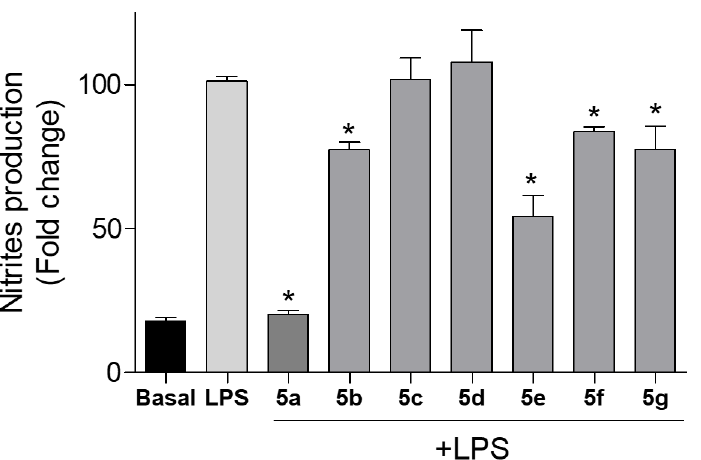
Figure 5. Effects of compounds 5a – 5g on NO release in microglial cells. Bv.2 microglial cells were cotreated with the compound at 10 μ M and 200 ng/mL LPS for 24 h. Nitrite accumulation in the culture media was measured using the Griess reagent. Results were expressed as a fold change relative to the LPS condition and mean ± SD (n ≥ 3 independent experiments performed in duplicate). Significant differences were determined by one-way ANOVA followed by Bonferroni t test; * p ≤ 0.05 vs. LPS.